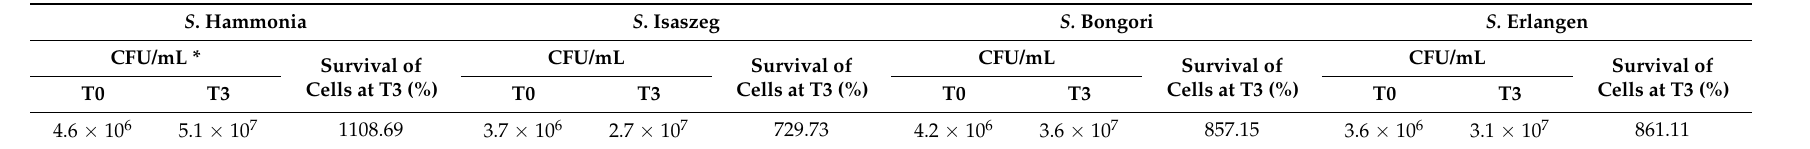
* CFU/mL—colony-forming units in